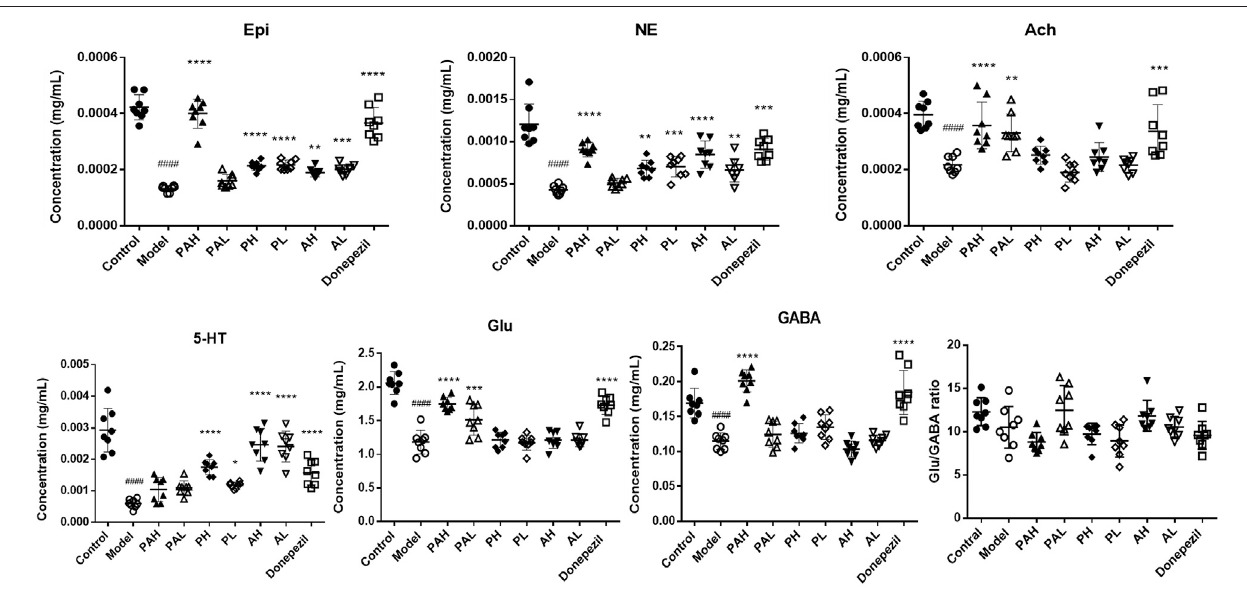
FIGURE 5 | Effect of PA on neurotransmitter levels in scopolamine-treated mice. Data represent mean ± S.D. ( n (cid:1) 8). #### p < 0.0001 vs control mice; * p < 0.05, ** p < 0.01, *** p < 0.001, and **** p < 0.001 vs scopolamine-treated mice.